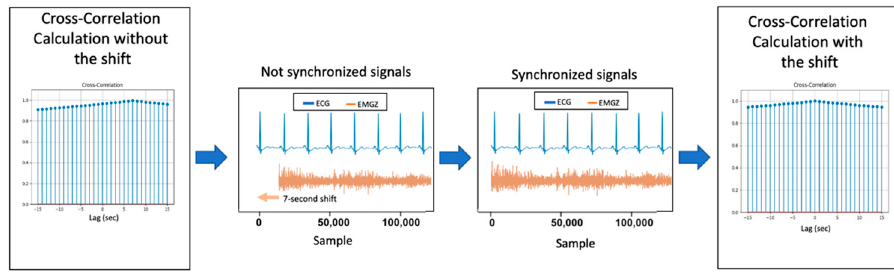
Figure 2. Process for time series synchronization.